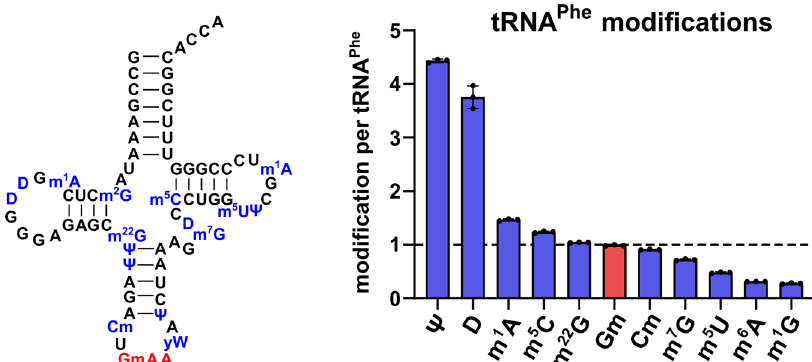
Fig. 1 Absolute quanti fi cation of human tRNA Phe GAA modi fi cations. The tRNA cloverleaf on the left shows the expected sequence of human tRNA Phe GAA including reported modi fi cations 32 . Right: Absolute quanti fi cation of puri fi ed tRNA Phe GAA from HEK 293 cells done by LC-MS/MS. All experiments are from n = 3 biol. replicates. Bars re fl ect the mean and error bars re fl ect